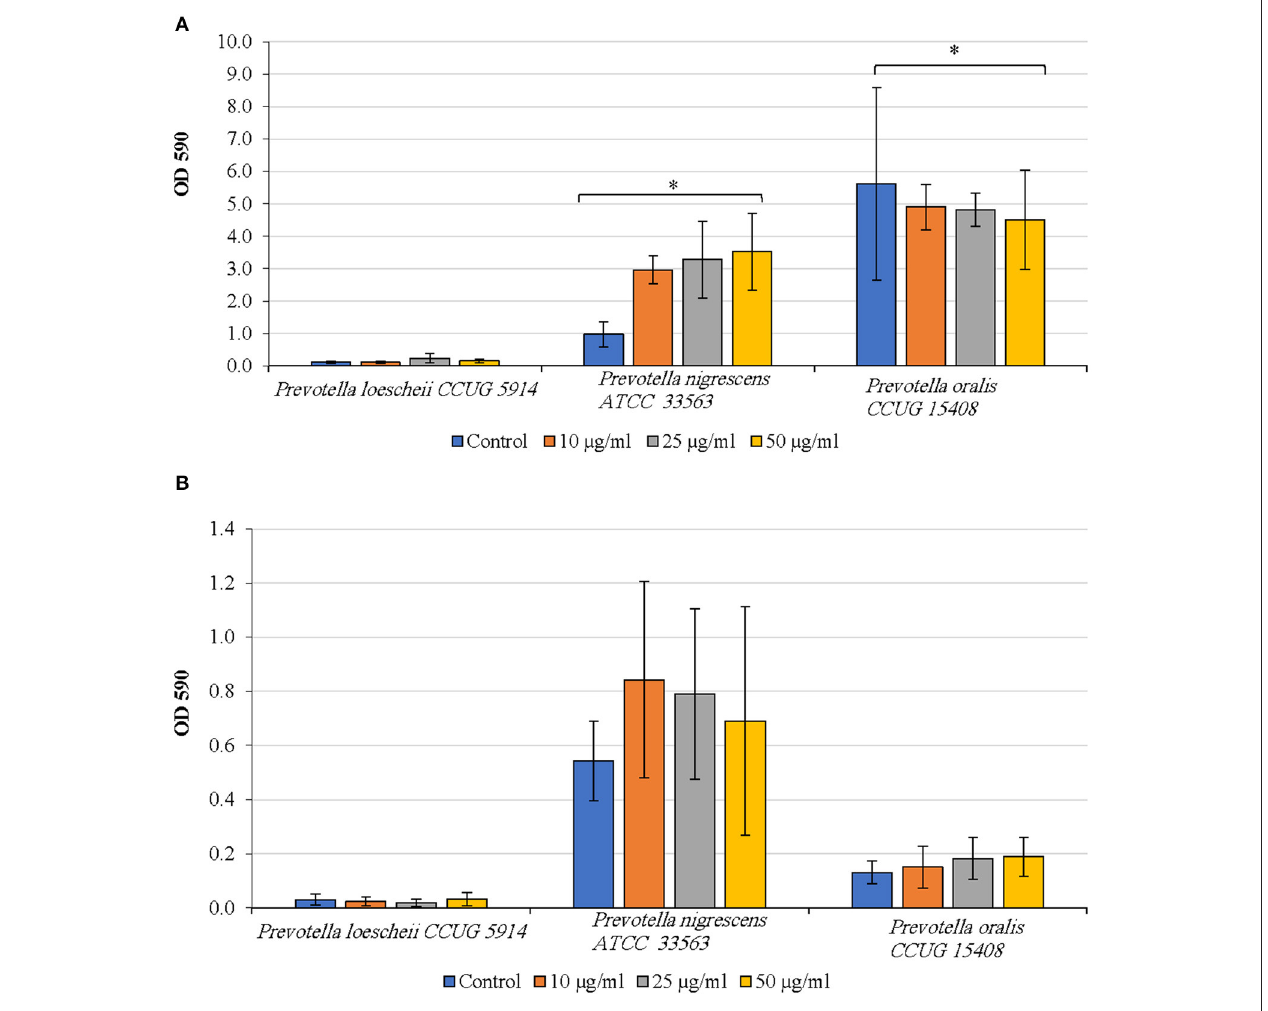
FIGURE 3 | (A) Inhibition of biofilm formation by DNase I. The effect of DNase treatment on the initiation and development of biofilms was studied. Different concentrations of DNase were added to the biofilm culture medium at the same time as the inoculum and incubated as described in the methods section. Biofilm mass was quantified using crystal violet technique. * P < 0.005, Mann Whitney. (B) Detachment of preformed biofilms by DNase I. The effect of DNase treatment on the preformed biofilms was studied. Different concentrations of the enzyme were added to the biofilm culture medium at the same time as the inoculum and incubated as described in the methods section. Biofilm mass was quantified using crystal violet technique. * P < 0.005, Mann Whitney.